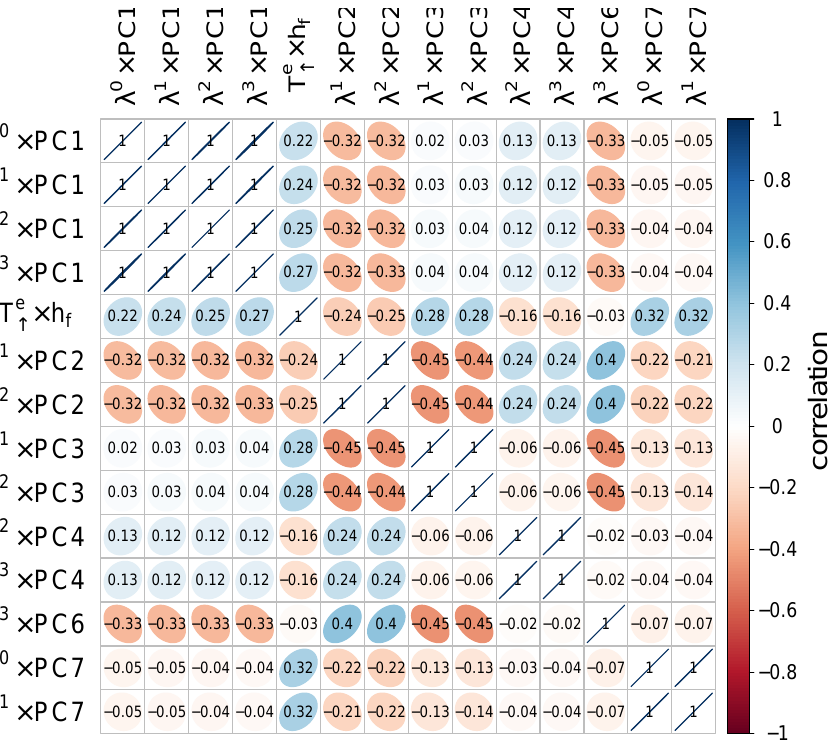
Figure 9. Correlation error matrix of a sample retrieval. A total of 10 PCs were supplied, atmospheric conditions were set to a middle latitude summer temperature profile, 955hPa surface pressure, 700–500hPa aerosol layer height, 0.05 aerosol optical thickness, 0.5gcm − 2 water vapor column. The retrieved/input SIF at 740nm amounts to 1 . 72 / 1 . 79mWm − 2 sr − 1 nm − 1